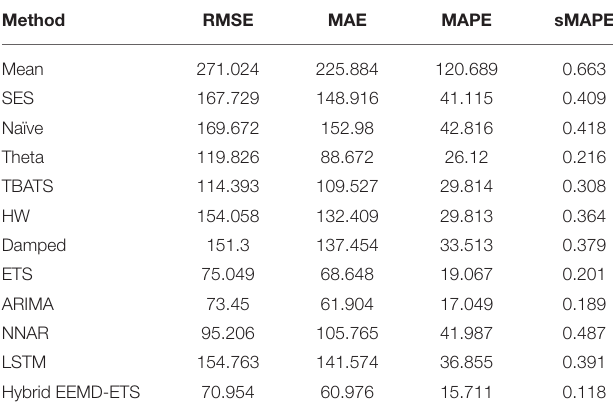
TABLE 12 | Performance comparison of different models for 7 days prediction of UK’s daily